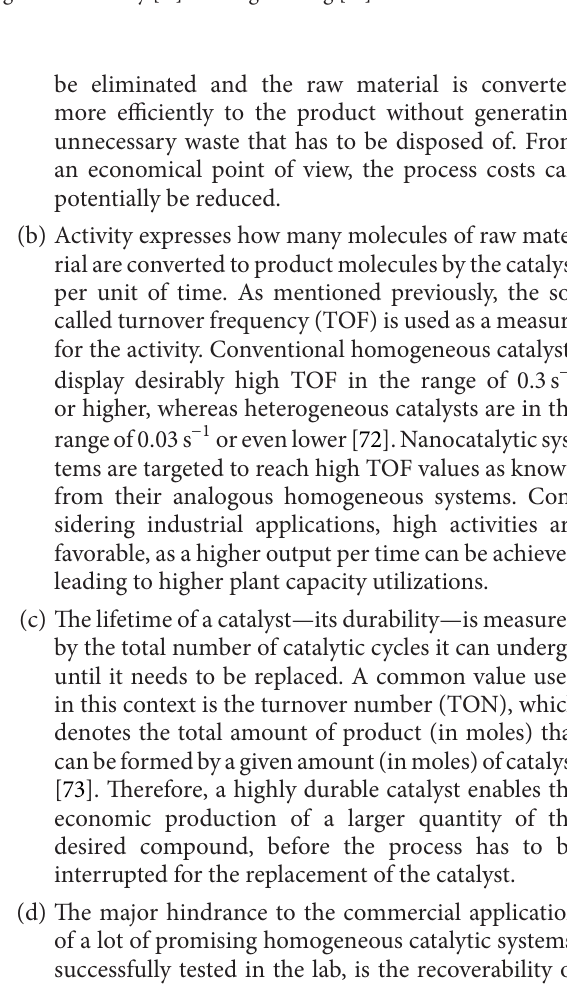
Figure 3: Potential contribution of nanocatalysis to green chemistry [11] and engineering